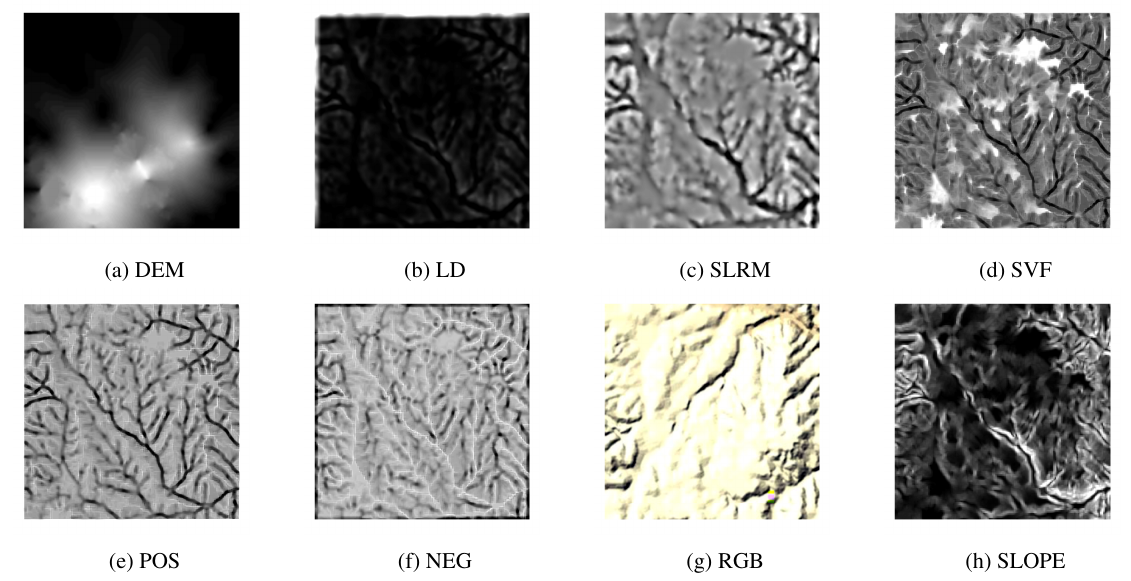
Figure 8. Examples of different raster derivatives for a fluvial landform.